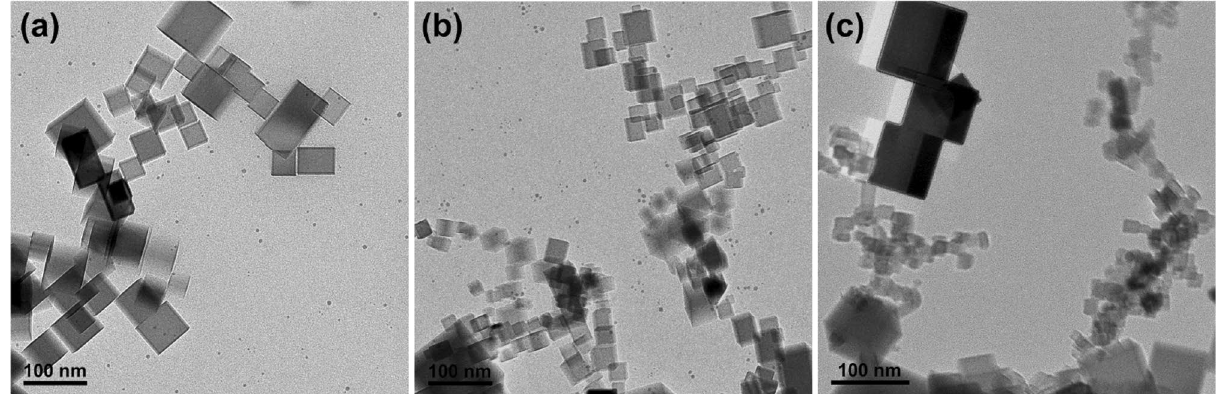
Figure 1. The typical TEM images of samples collected from ( a ) neutral, ( b ) positive, and ( c ) negative Mg particle flames. Sub-ten nanometer-size clusters (small dots) are seen together with mature cubical